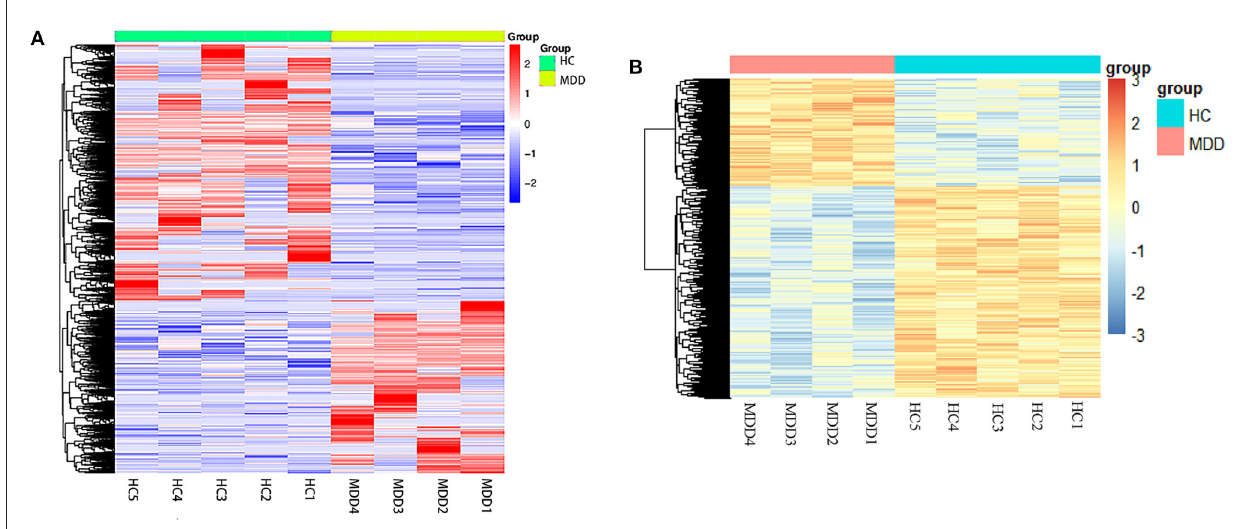
FIGURE2 Heatmap of differentially expressed mRNA and DNA methylation positions in first-episode, drug-naive adolescents with MDD. Hierarchical clustering of mRNAs (A) and DNA methylation positions (B) between first-episode, drug-naive adolescents with MDD and healthy controls (HCs). The results showed different patterns between the two groups and homogeneity within each group. Red and blue indicate up- or down-regulation (hyper-methylated or hypo-methylated), respectively, in